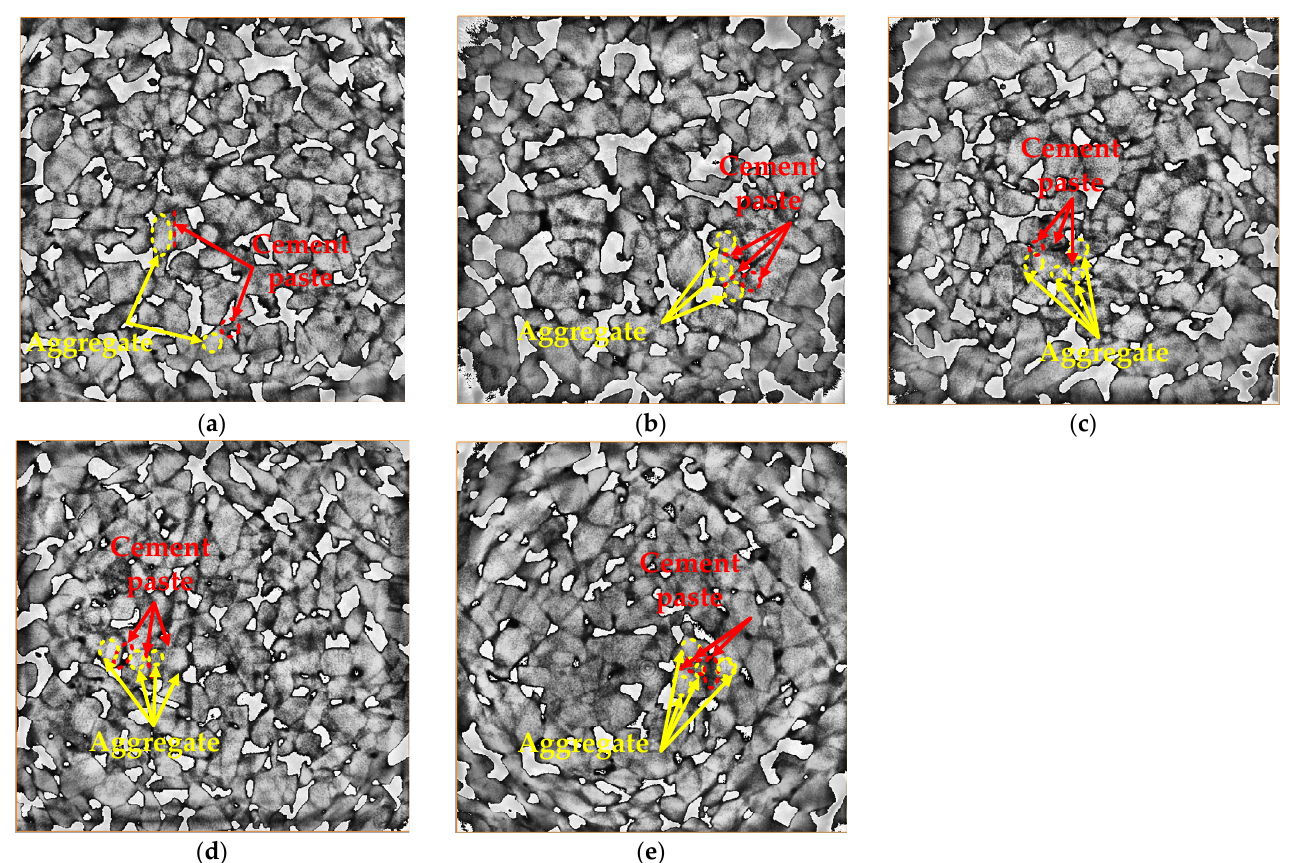
Figure 17. The 2D images of cross sections of the specimens with different levels of content of basalt fiber: ( a ) 0 kg/m 3 , ( b ) 2 kg/m 3 , ( c ) 4 kg/m 3 , ( d ) 6 kg/m 3 , and ( e ) 8 kg/m 3 .